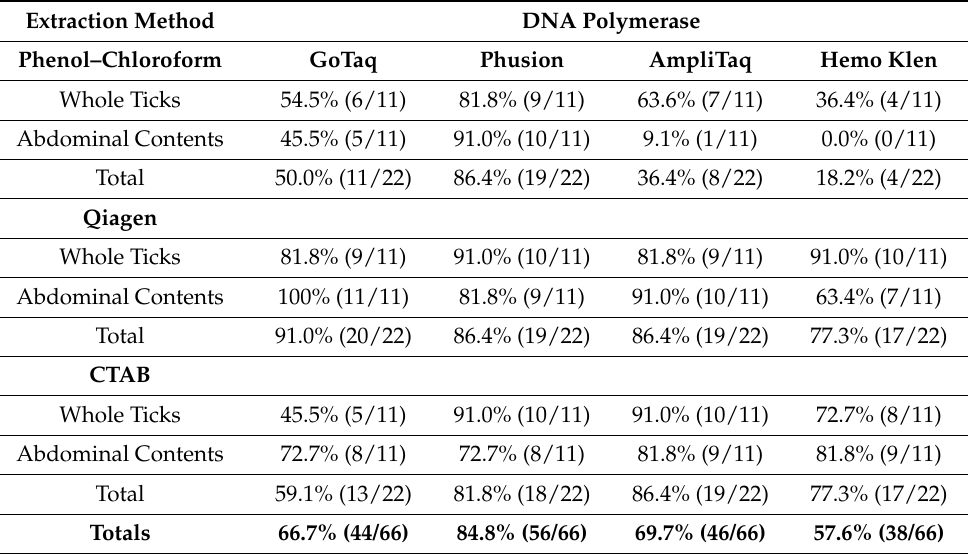
Table 1. Percentage amplification of DNA extracted from engorged ticks by four commercially available DNA polymerase